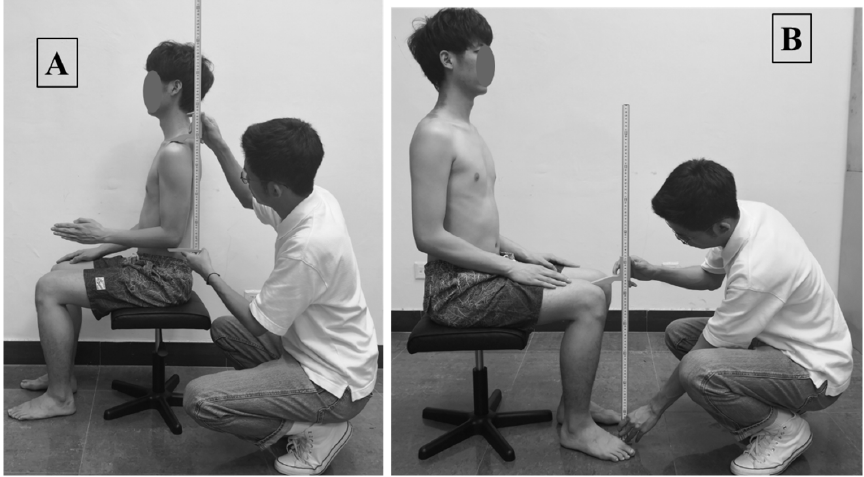
Figure 1. Sample picture captured during measurements. Note: ( A ) shoulder ‐ elbow length; ( B ) knee height.